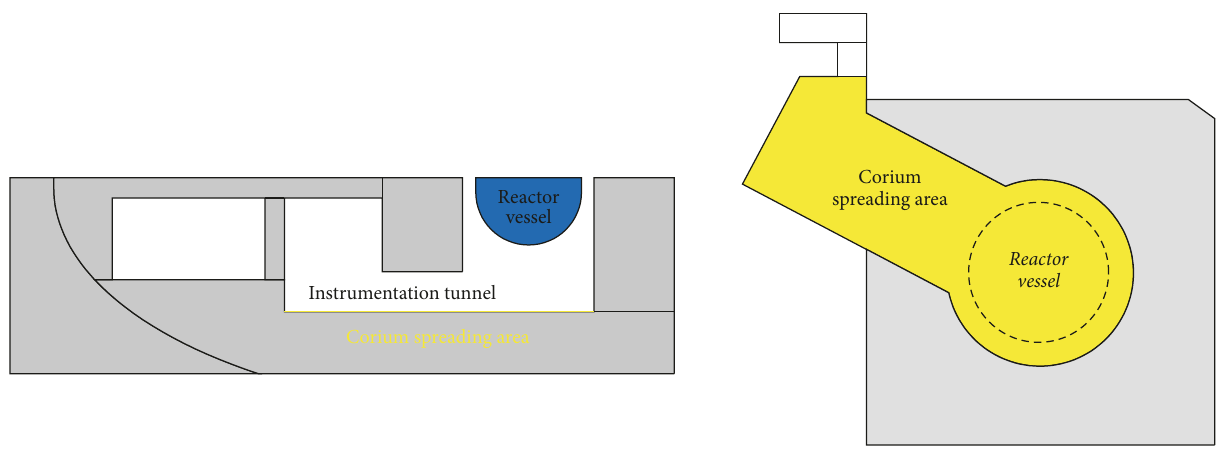
Figure 5: Corium spreading area (a cross section and a floor plan). Table 1: Time sequence of main events during the in-vessel